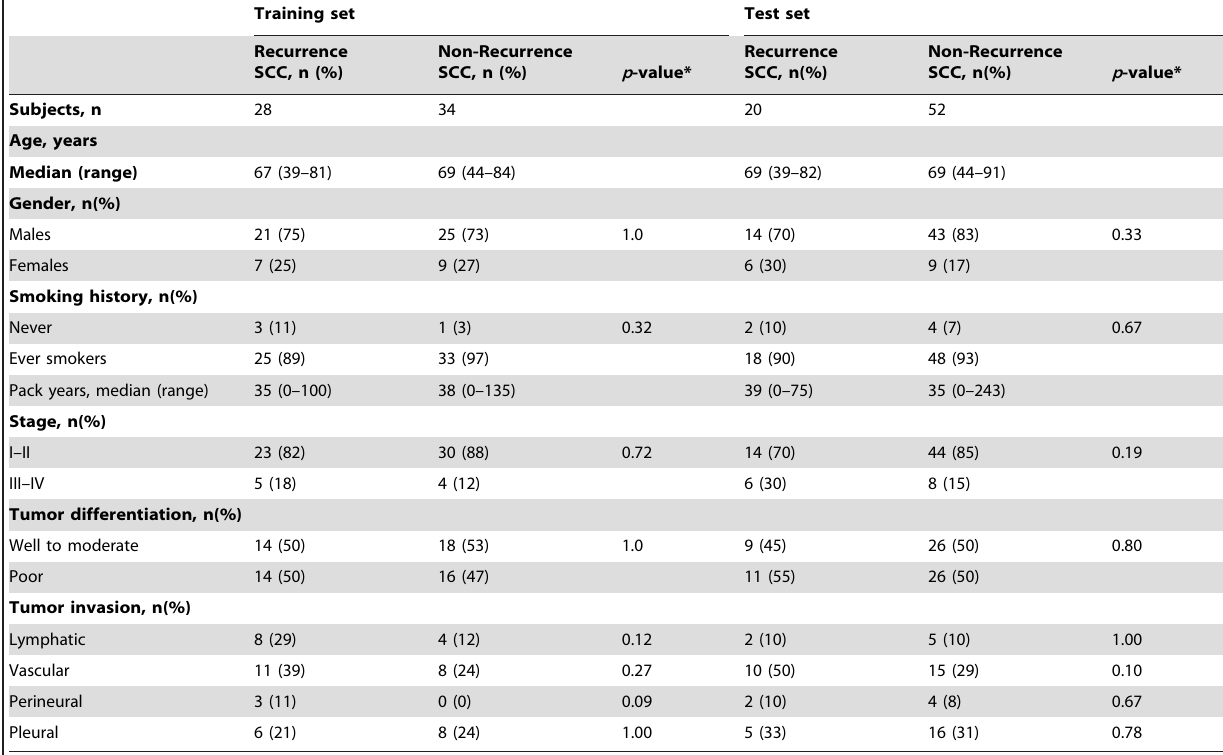
Table 1. Subject